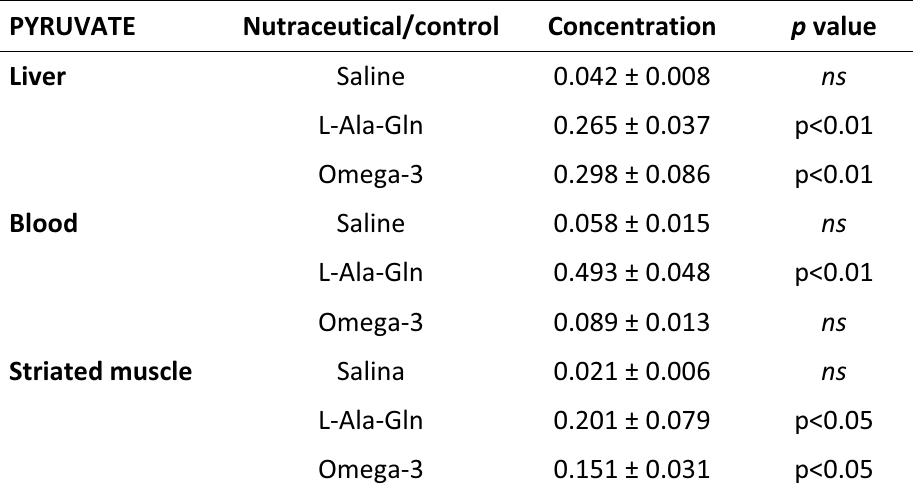
TABLE 1 - Mean pyruvate concentrations in the blood (µmol/ml) and tissue (mol/g) in groups G1 - treated with saline, G2 - treated with L-Ala-Gln and G3 - treated with Omega-3, 48 hours after sepsis